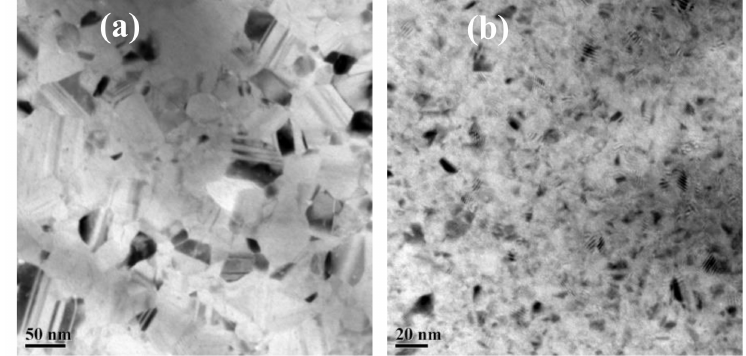
Figure 4. Bright-field TEM images of ( a ) the as-deposited Cu and ( b ) Cu-7.3%Zr thin